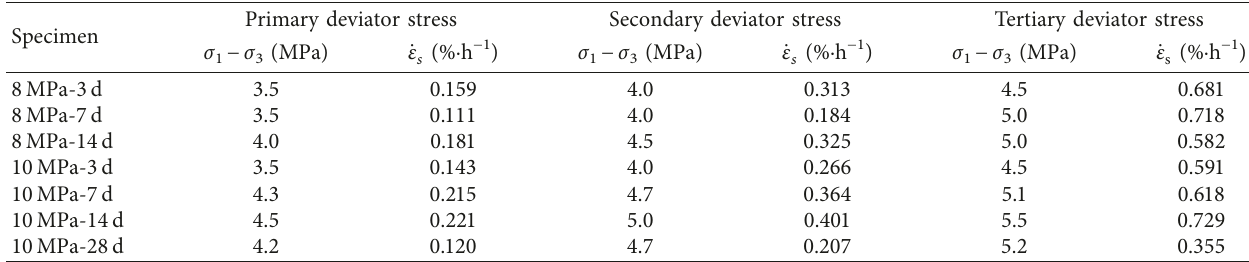
Table 3: The steady creep rate of the frozen clay specimens ( − 15 °